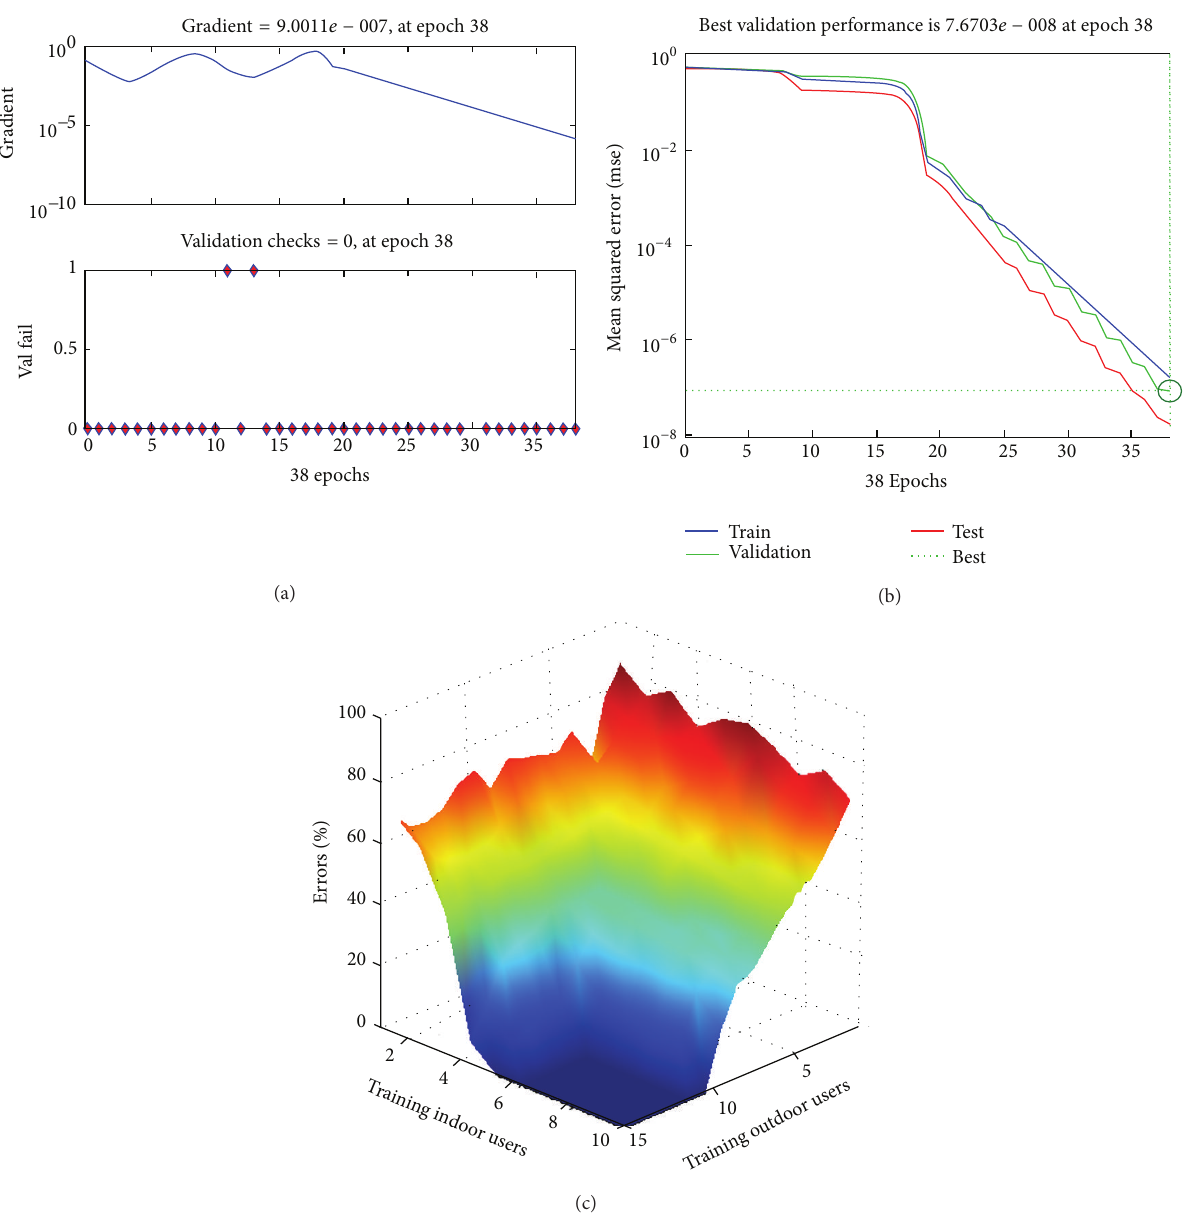
Figure 6: (a) Training state and (b) performance of best validation. (c) Performance of femtocell for different number of